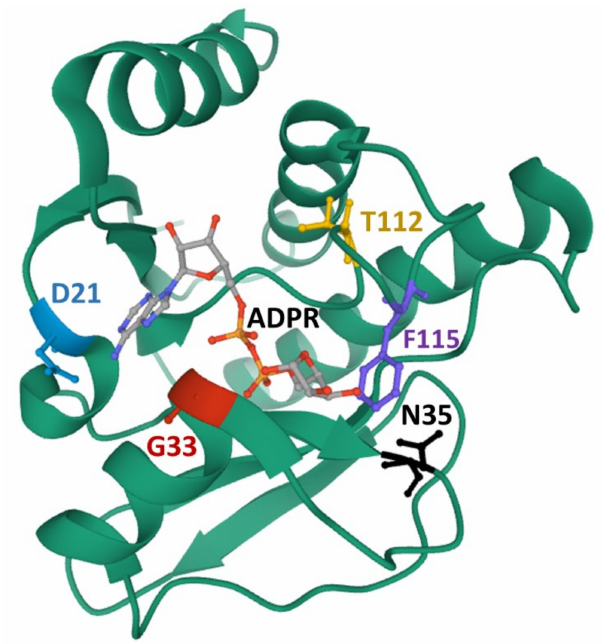
Figure 4. The crystal structure of the VEEV macrodomain protein [11] was downloaded from the PDB (doi:10.2210 / pdb5mqx / pdb): Highlighted residues are D21 (blue, D20 in chikungunya virus (CHIKV)); N35 (black, N34 in CHIKV); G33 (red, G32 in CHIKV); T112 (yellow, T111 in CHIKV); and F115 (purple, Y114 in CHIKV). ADP-ribose (ADPR) is also